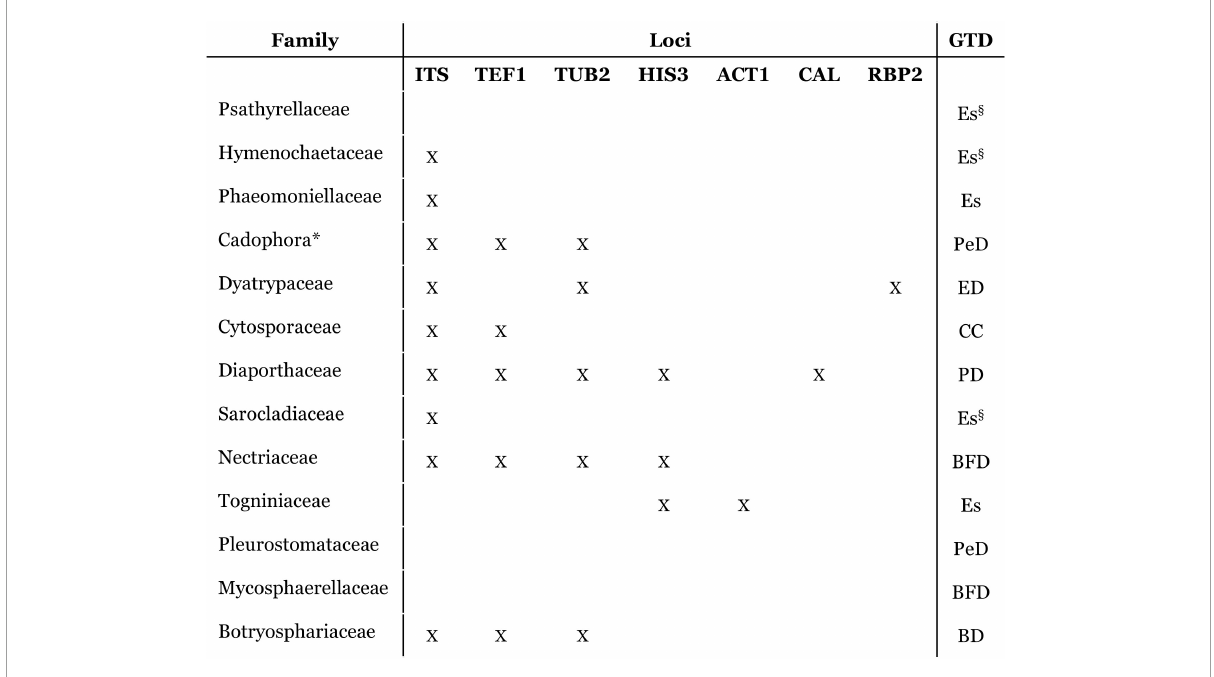
FIGURE3 Schematic representation of the accepted grapevine trunk disease (GTD)-causing fungal families, indicating the loci that are usually used for species identification within each fungal family (Cabral et al., 2012; Arzanlou et al., 2013a; Yan et al., 2013; Rolshausen et al., 2014; Travadon et al., 2015; Lawrence et al., 2017; Dissanayake et al., 2018; Guarnaccia et al., 2018; Gramaje et al., 2019) in those in which these are applicable. Several families need multi- loci analysis to accurately identify species. Esca (Es), Petri disease (belonging to Esca complex) (PeD), Botryosphaeria dieback (BD), Eutypa dieback (ED), Phomopsis dieback (PD), black foot disease (BF), and Cytospora Canker (CC). Cadophora is a fungal genus and is therefore indicated (*) for easier comparison to other fungal families. Families/genera which are not recognized to be involved in Petri disease, and therefore do not affect young vines, but have a role in esca-affected mature vines are indicated (Es §